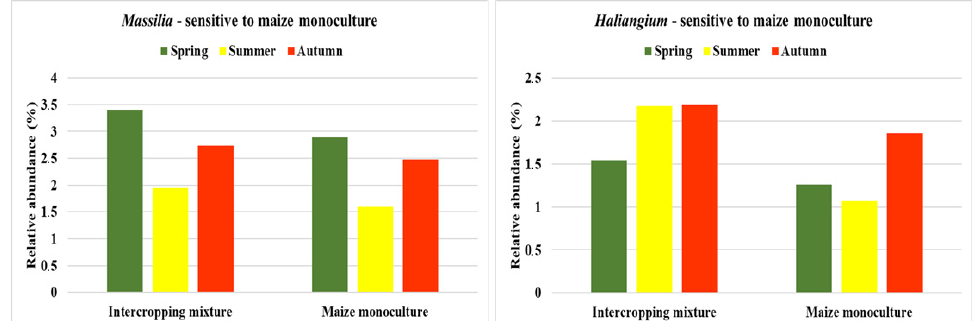
Figure 7. Bacterial genera recommended as sensitive to maize monoculture in all studied seasons .